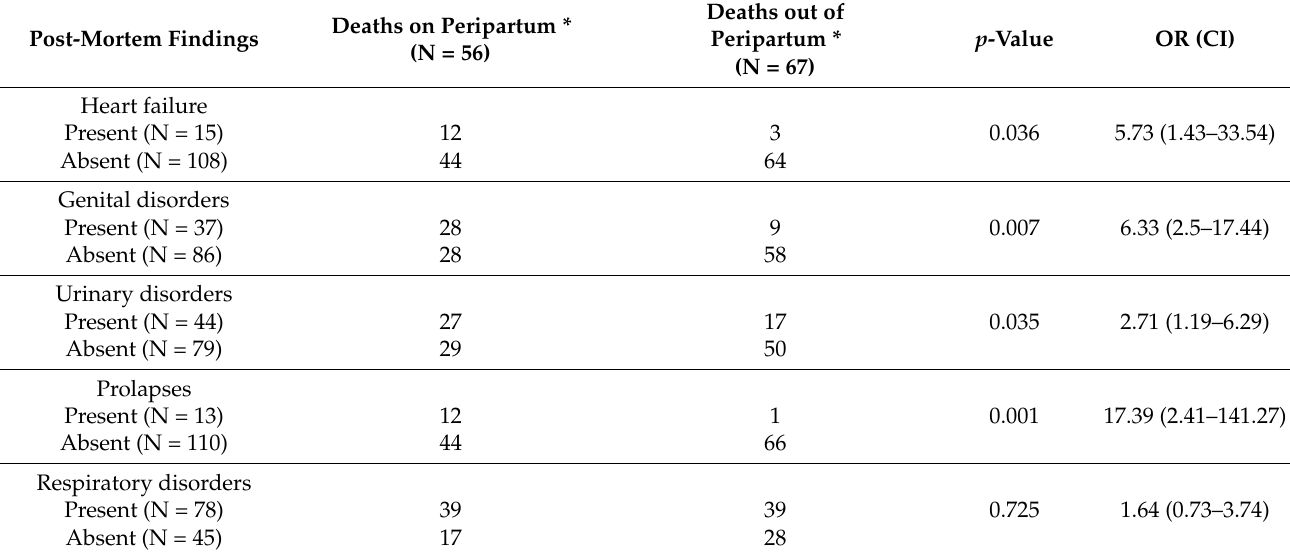
Table 1. Risk factors for post-mortem findings.